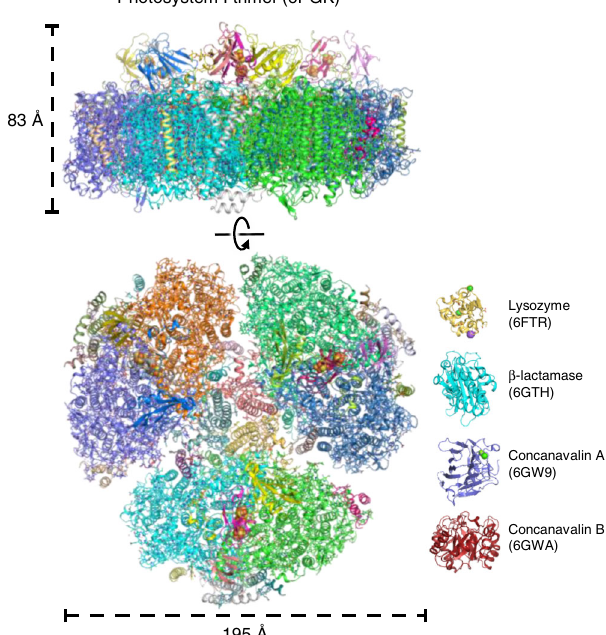
Fig. 4 Comparison of SFX structures from the EuXFEL. The structure of the trimeric PSI determined in this study is shown to scale with the four protein structures previously solved at the EuXFEL by using MHz repetition rates for comparison. Views from the membrane plane (top) and membrane normal (bottom) are shown for the PSI trimer, with major and minor axes denoted. Protein subunits are colored